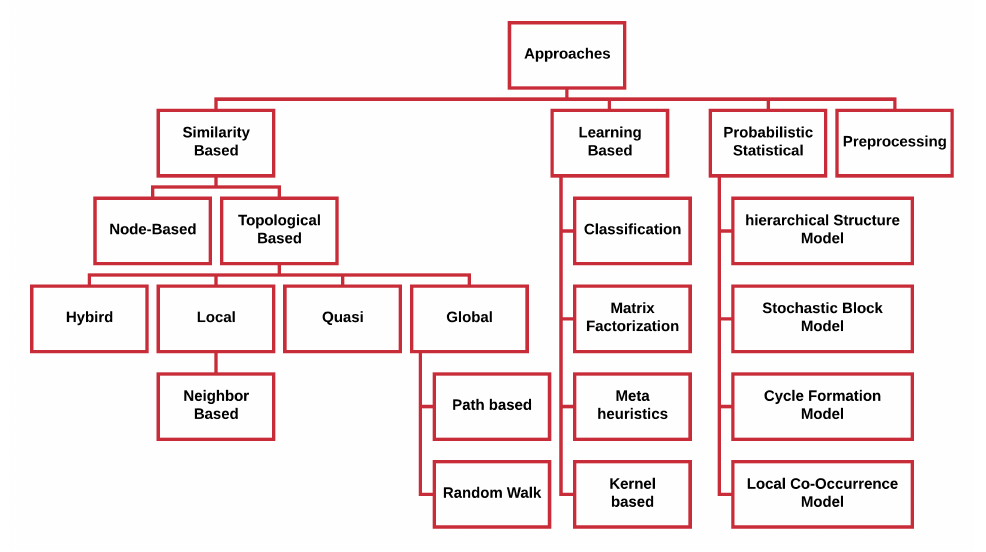
Figure 5. Taxonomy of Link Prediction